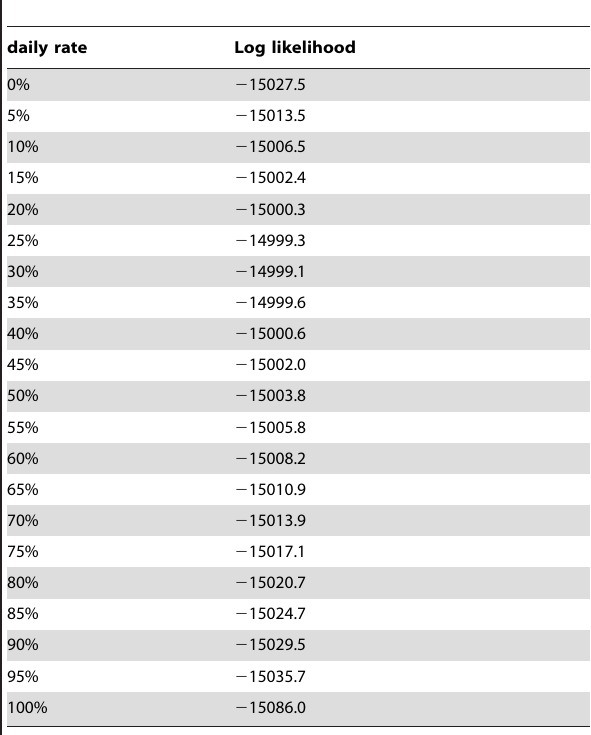
Table 3. Model summary of varying daily acclimatization